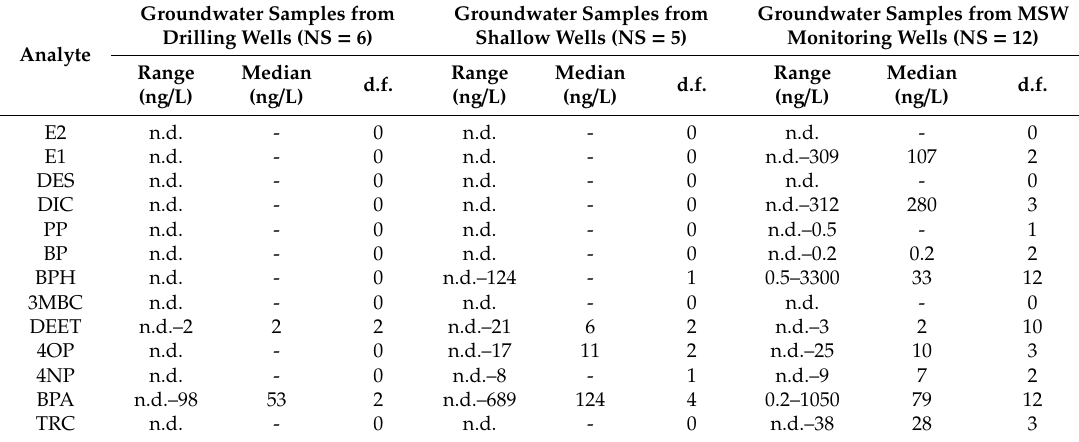
Table 5. The ECs concentrations (ng / L; range and median) in groundwater samples from deep wells, shallow wells, and monitoring wells located in two municipal solid waste (MSW) landfill sites with detection frequencies.